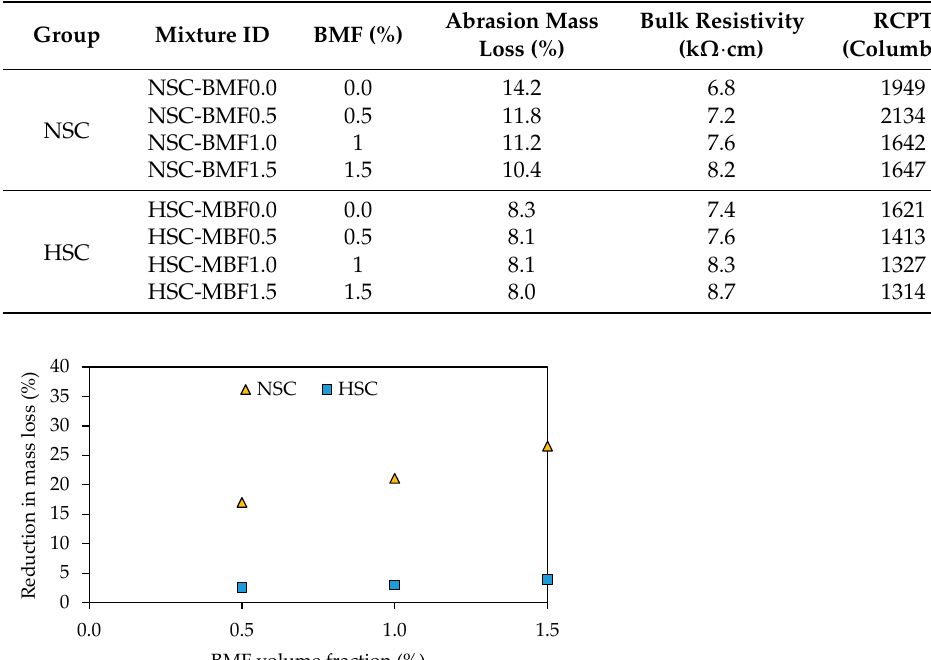
Table 10. Abrasion mass loss, bulk resistivity, and RCPT test results.